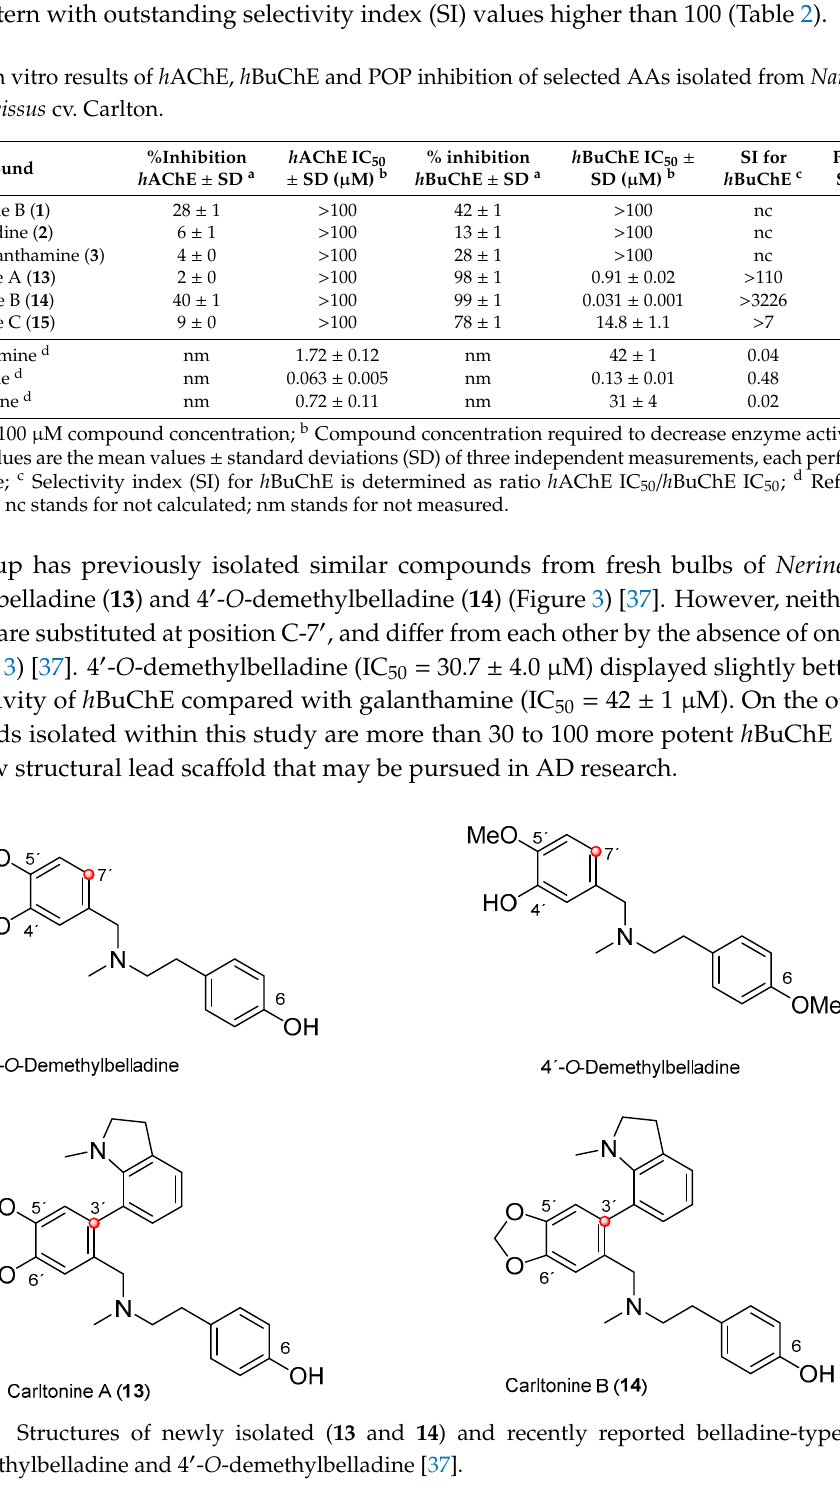
Table 2. In vitro results of h AChE, h BuChE and POP inhibition of selected AAs isolated from Narcissus pseudonarcissus cv. Carlton Compound